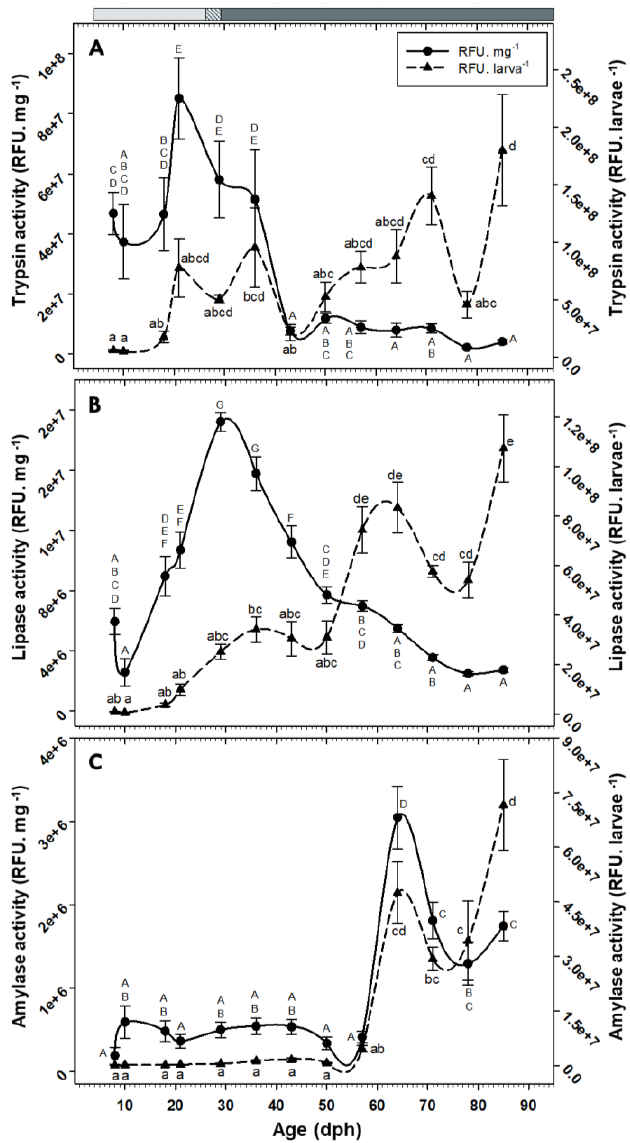
Figure 6. Changes in the activity of trypsin ( A ), lipase ( B ), and amylase ( C ) in C. labrosus individuals during development (N = 7 to 13 individuals per sampling point). The rest of legend as in Figure 2.